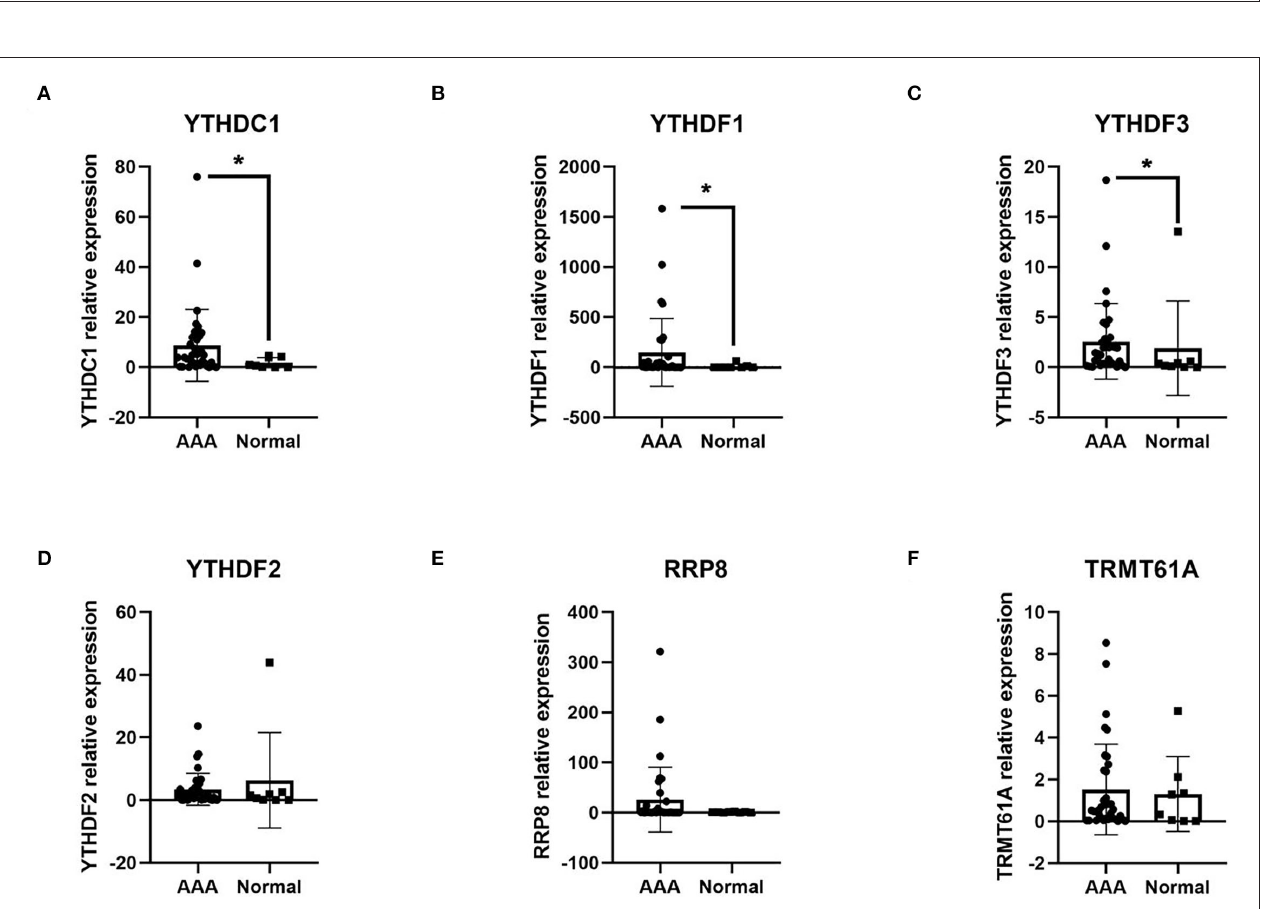
FIGURE 4 | between YTHDF3 and M1 macrophages; (E) Scatter plot of the correlation between YTHDF1 and M1 macrophages; (F) Scatter plot of the correlation between YTHDF2 and M1 macrophages; (G) Scatter plot of the correlation between YTHDF1 and M2 macrophages; (H) Scatter plot of the correlation between YTHDF3 and M2 macrophages; (I) Correlation heat map of the relationships between DEMRGs and immune cells, with red representing positive correlation, blue representing negative correlation and NA representing no statistical significance.